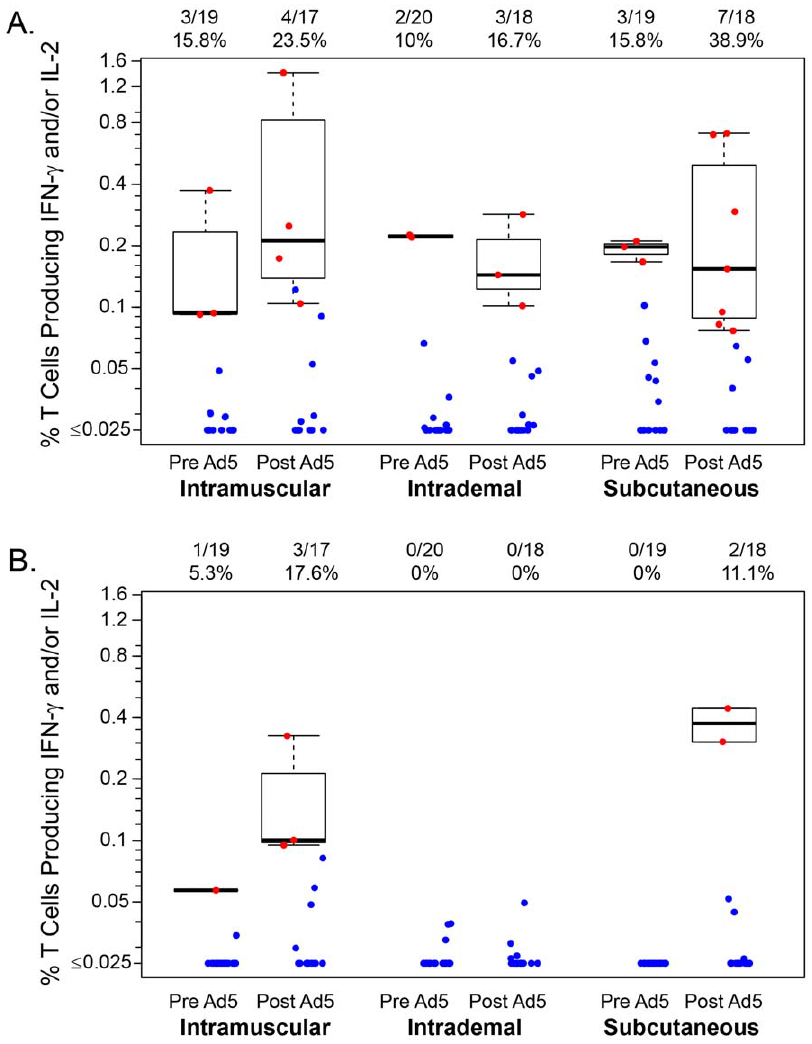
Figure 5. Percentage of CD8 + T cells producing interferon c and/or Interleukine 2 by administration route. (A) in response to any Env peptides (B) in response to any Pol peptides before (2 weeks post last DNA prime) and after the Ad5 boost (4 weeks post Ad5 boost).